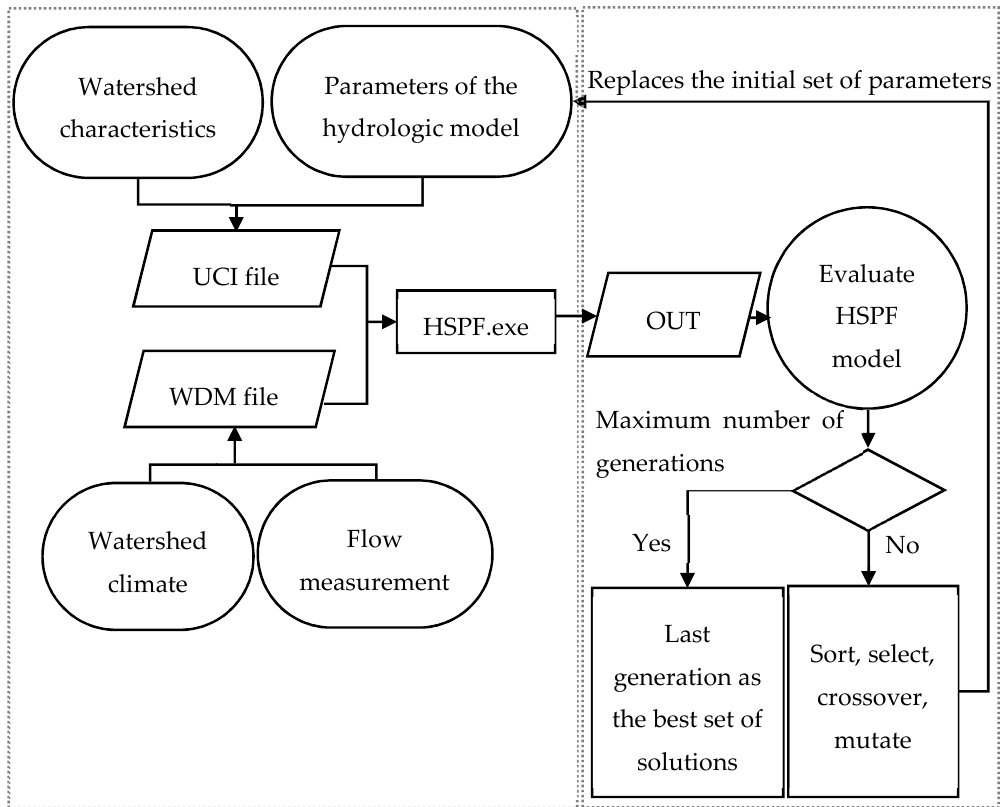
Figure 3. Relation between the HSPF model and non-sorted genetic algorithm II (NSGA-II) to find the best optimal solution.